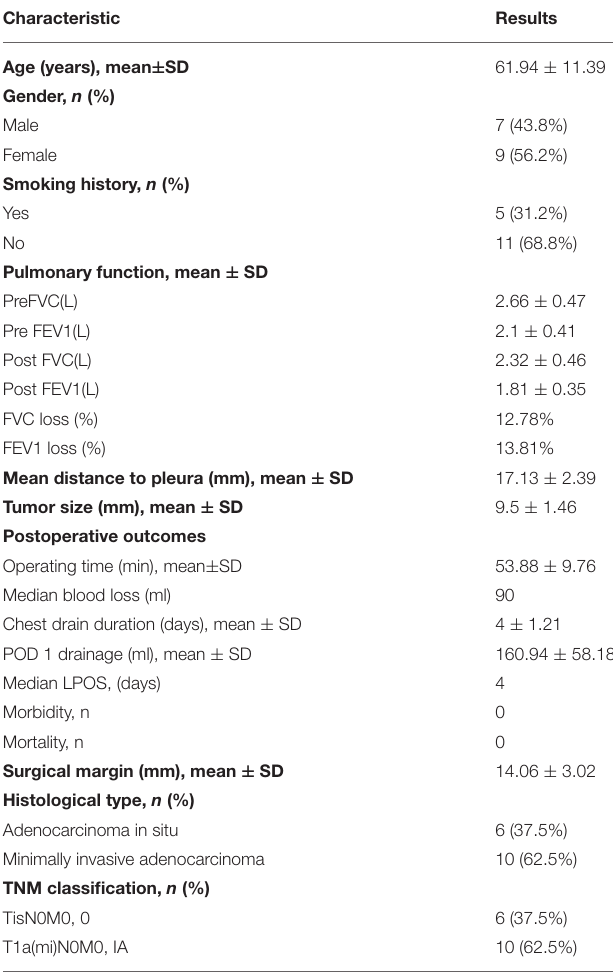
TABLE 1 | Patient clinicopathologic